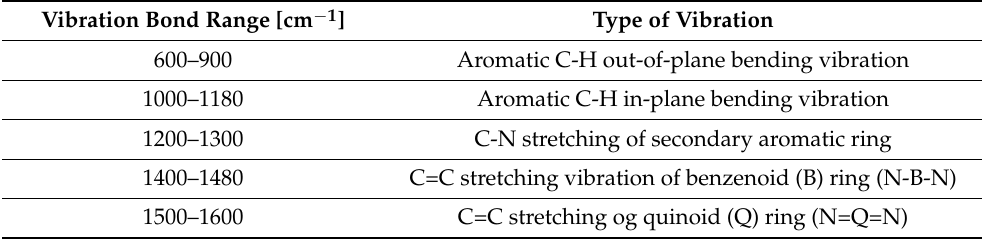
Figure 5. FTIR of scaffold: ( a ) before and ( b ) after immersion in SBF. The spectrum of PCL presents a set of typical bands at 1157 cm − 1 and 1293 cm − 1 (C − O, C − C stretching), 1175 cm − 1 and 1240 cm − 1 (C − O − C, symmetric and asymmetric stretching, respectively) strong absorption band at 1727 cm − 1 (C=O, stretching), 2865 cm − 1 and 2949 cm − 1 (CH 2 , asymmetric stretching). Although spectra of the PCL/n-HAp comprise the leading characteristic bands of PCL, some supplementary bands emerge, proving the presence of n-HAp. These new bands are located at 605 and 566 cm − 1 ( ν 4 PO 43 − ) and 1033 cm − 1 ( ν 3 PO 43 − ), although the PCL spectrum overlapped this band. The characteristic bands of PANI are shown in Table 1. Table 1. Assignment of FTIR bands for PANI [30].